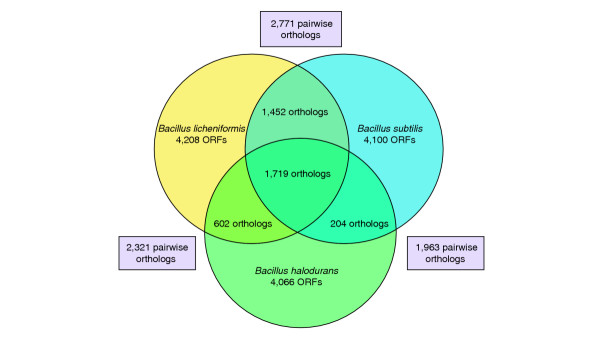
Venn diagram comparing the orthologous gene complements of B. licheniformis ATCC 14580, B. subtilis 168 and B. halodurans C-125. Numbers in purple boxes indicate the number of pairwise orthologs between adjacent species (BLAST threshold E = 1 × 10-5). Numbers in the outer circles represent the total number of CDSs predicted in each genome, numbers in areas of overlap indicate the number of orthologs predicted by reciprocal BLASTP analysis (threshold E = 1 × 10-5), and the number in the center gives the number of orthologous sequences common to all three genomes.